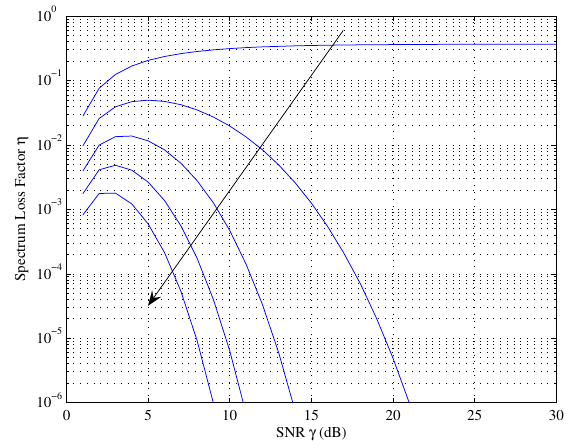
Figure 5. The efficiency-oriented scheme for SCoS with I ≤ N k = N 0 . Along the direction of the arrow, N = 1 , 2 , 3 , 4 , 5 . connect the fusion center and the secondary users, which is impractical for mobile secondary